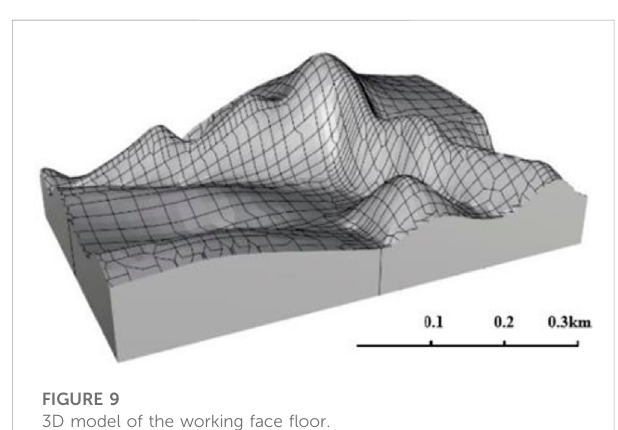
FIGURE 9 3D model of the working face fl oor.